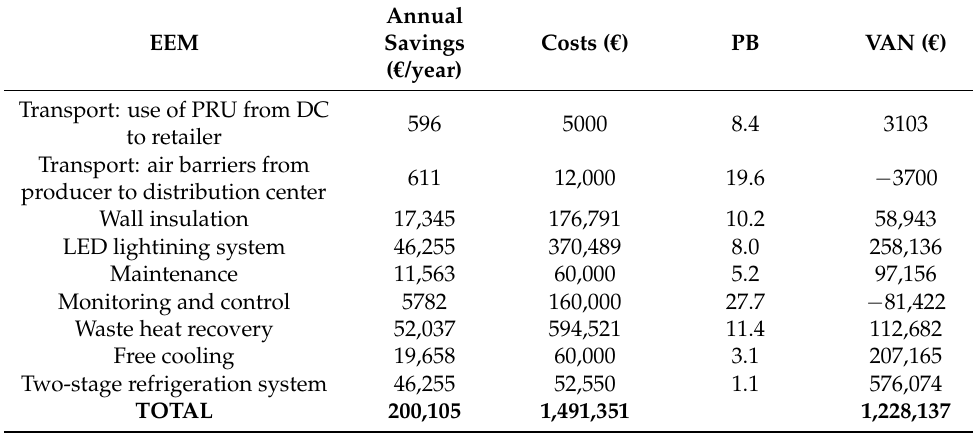
Table 4. Economic analysis of the energy efficiency